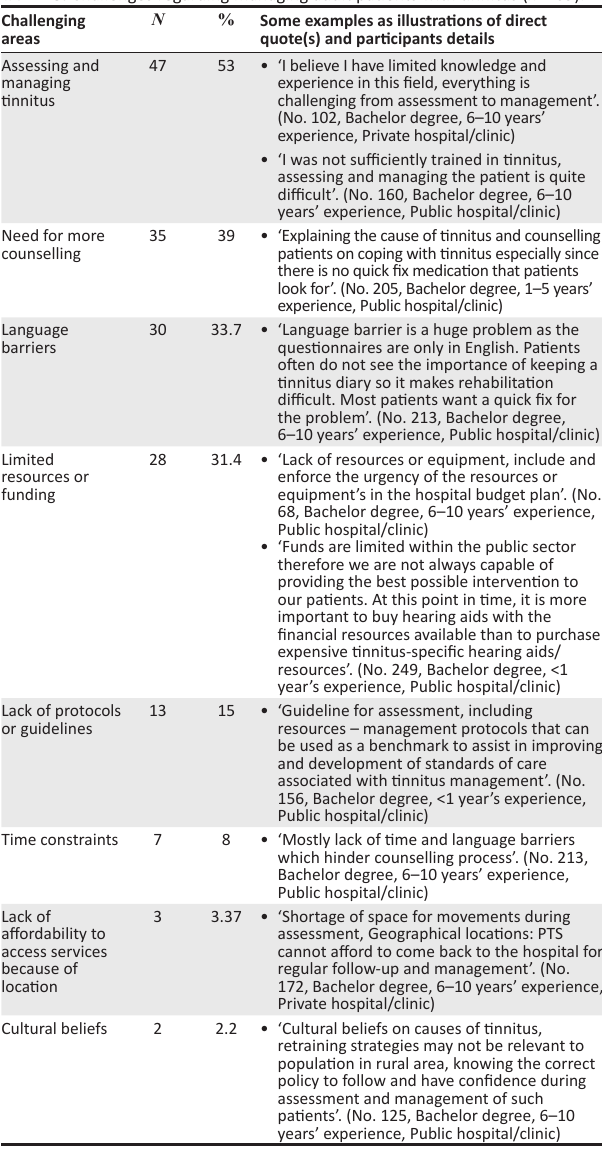
TABLE 8: Challenges regarding managing adult patients with tinnitus ( n = 89). Challenging areas